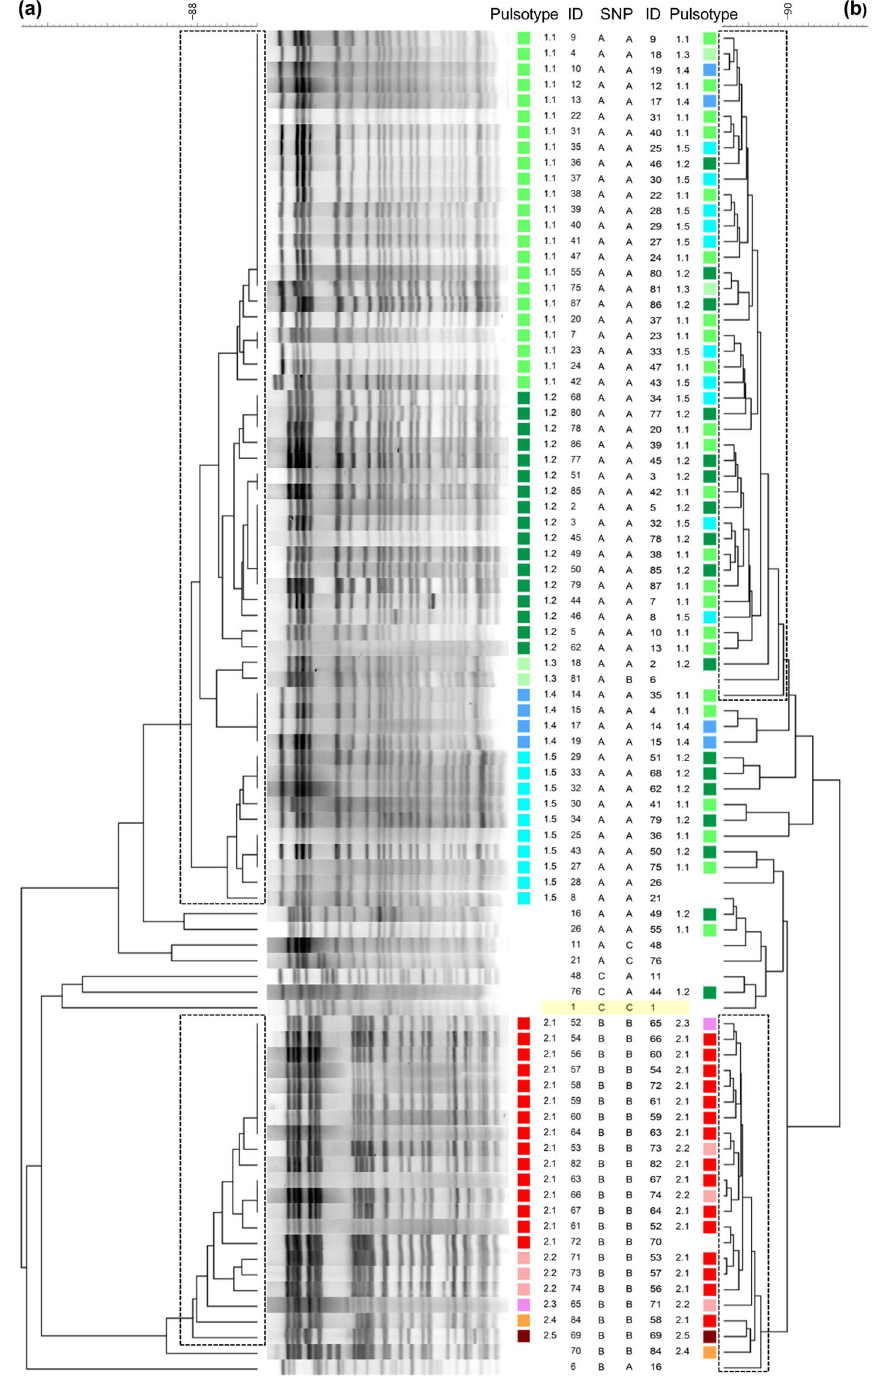
Figure 2. Clustering of the SØ12 VRE isolates. ( a ) Dendrogram of SmaI macro-restriction pattern resolved in PFGE of VRE E . faecium with vanA . The UPGMA tree illustrates the distance between isolates. The two boxes show the two main clusters of isolates displaying > 88% similarity, while the pulsotypes defined with > 94% similarity and visual inspection are differentiated with colors and number. Pulsotype 1.1–1.5 (green/blue) belongs to cluster 1, while pulsotype 2.1–2.5 (red/pink/brown) belongs to cluster 2. The index case strain (ID 1) is highlighted with a yellow box. (b) Dendrogram of the same isolates of VREfm resolved with MALDI-TOF MS. The two boxes indicate the two main clusters identified with > 90% similarity. The pulsotypes are assigned by PFGE in ( a